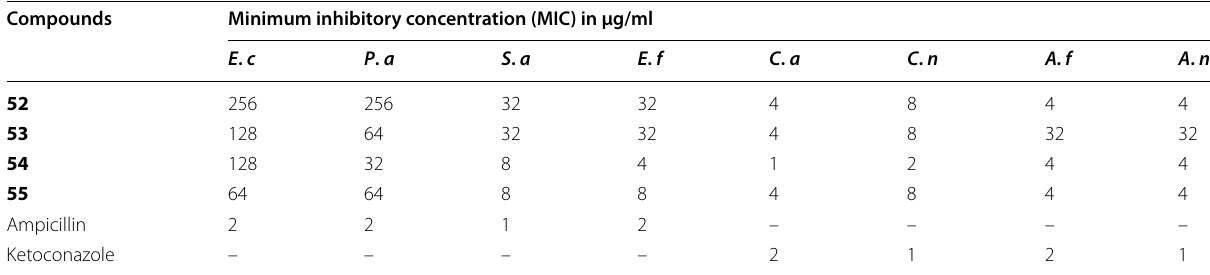
Table 16 Antimicrobial activities of synthesized compounds